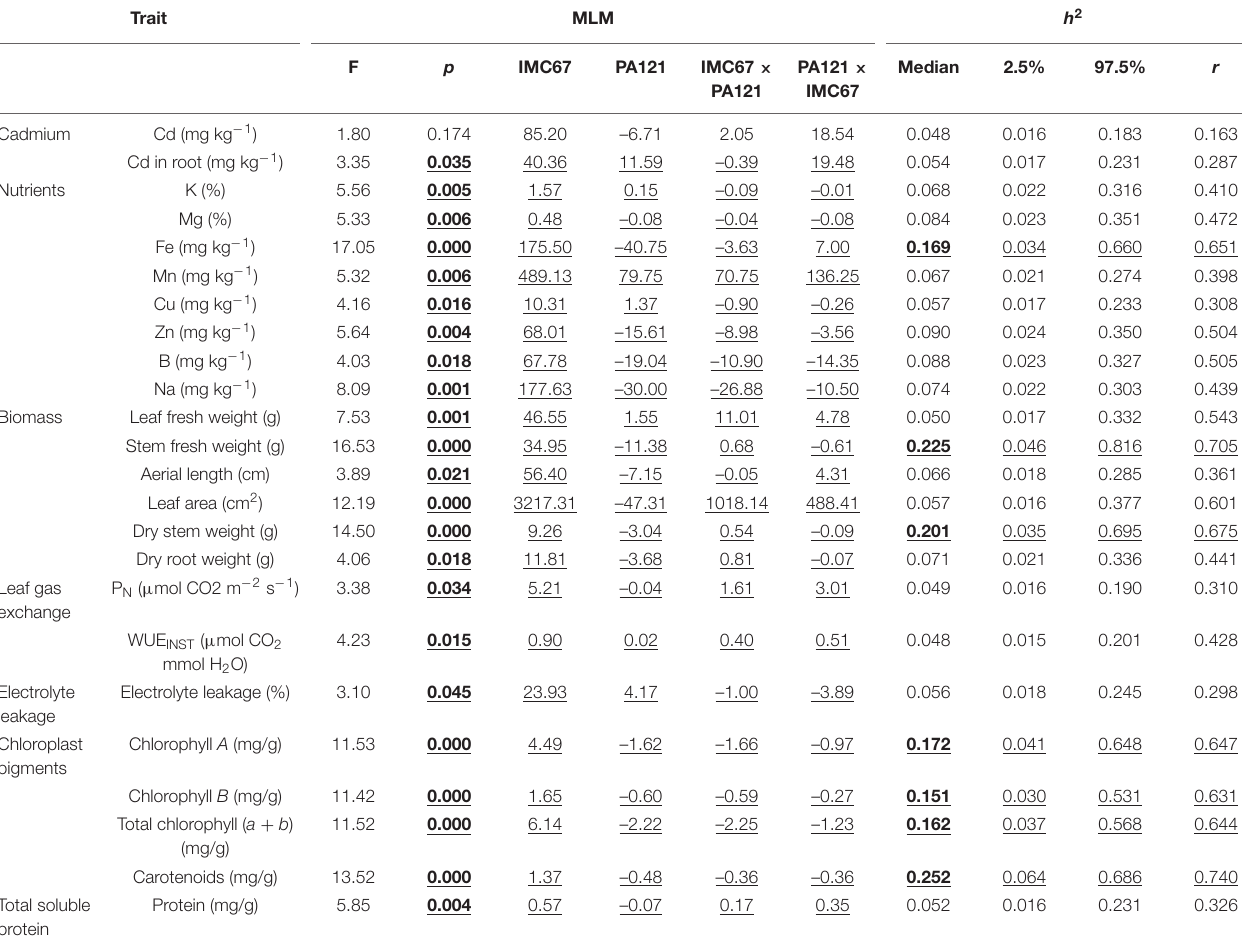
TABLE 1 | Specific combining abilities and narrow-sense heritability ( h 2 ) in cacao seedlings from controlled crosses before grafting. Trait